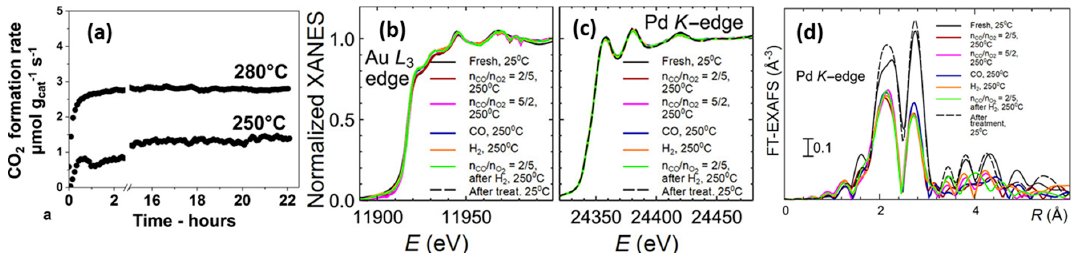
Figure 11. ( a ) CO oxidation stability test results of Pd 0.09 Au 0.91 RCT-SiO 2 . Reaction conditions: 5% ( V / V ) CO, 10% ( V / V ) O 2 , He balance; GHSV = 2000 h − 1 , total flow rate = 25 mL min − 1 ; m cat = 40 mg. ( b ) In situ XANES spectra for the Au L 3 edge and ( c ) the Pd K edge for Pd 0.09 Au 0.91 RCT-SiO 2 under reaction conditions. ( d ) Corresponding Fourier-transformed k 2 -weighted EXAFS spectra for the Pd K edge. Adapted with permission from Ref. [172]. Copyright 2019 American Chemical Society.